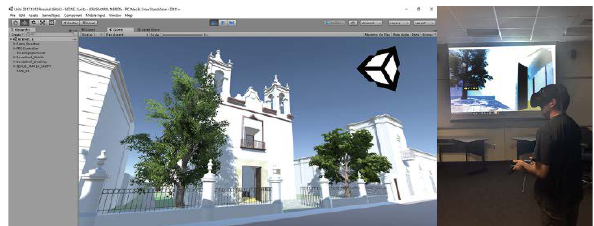
Figure 10. First pilot experiences with virtual interactivity at the Missouri State University (USA), using as a basis the historical phase of the reconstruction of the Jesús María temple (second half of the 19 th century); the Unity videogame platform and the HTC Vibe hardware were